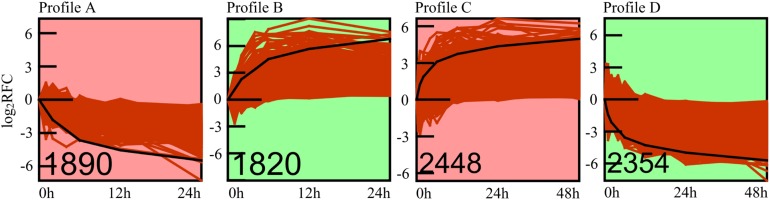
Significant gene expression profiles. The number of genes of each profile is shown at left bottom of each frame. The red curves represent the expression patterns of each gene. The black line represents the model expression pattern. The y axis represents log2 (RFC) of expression values, and the x axis represents the time points. RFC, relative fold change.